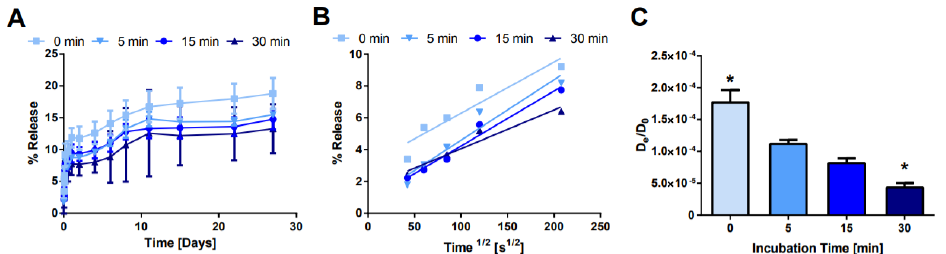
Figure 7. Effect of NS/AO incubation time on release. ( A ) Bulk release of AO from hydrogels with varying NS/AO incubation times with NS concentration of 1 mg/mL. ( B ) Fractional release as a function of the square root of time. ( C ) Effective diffusion coefficient for each condition. * indicates statistically significant difference from all other groups ( n = 3, p < 0.05) as indicated by an ANOVA followed by Tukey’s post hoc test.